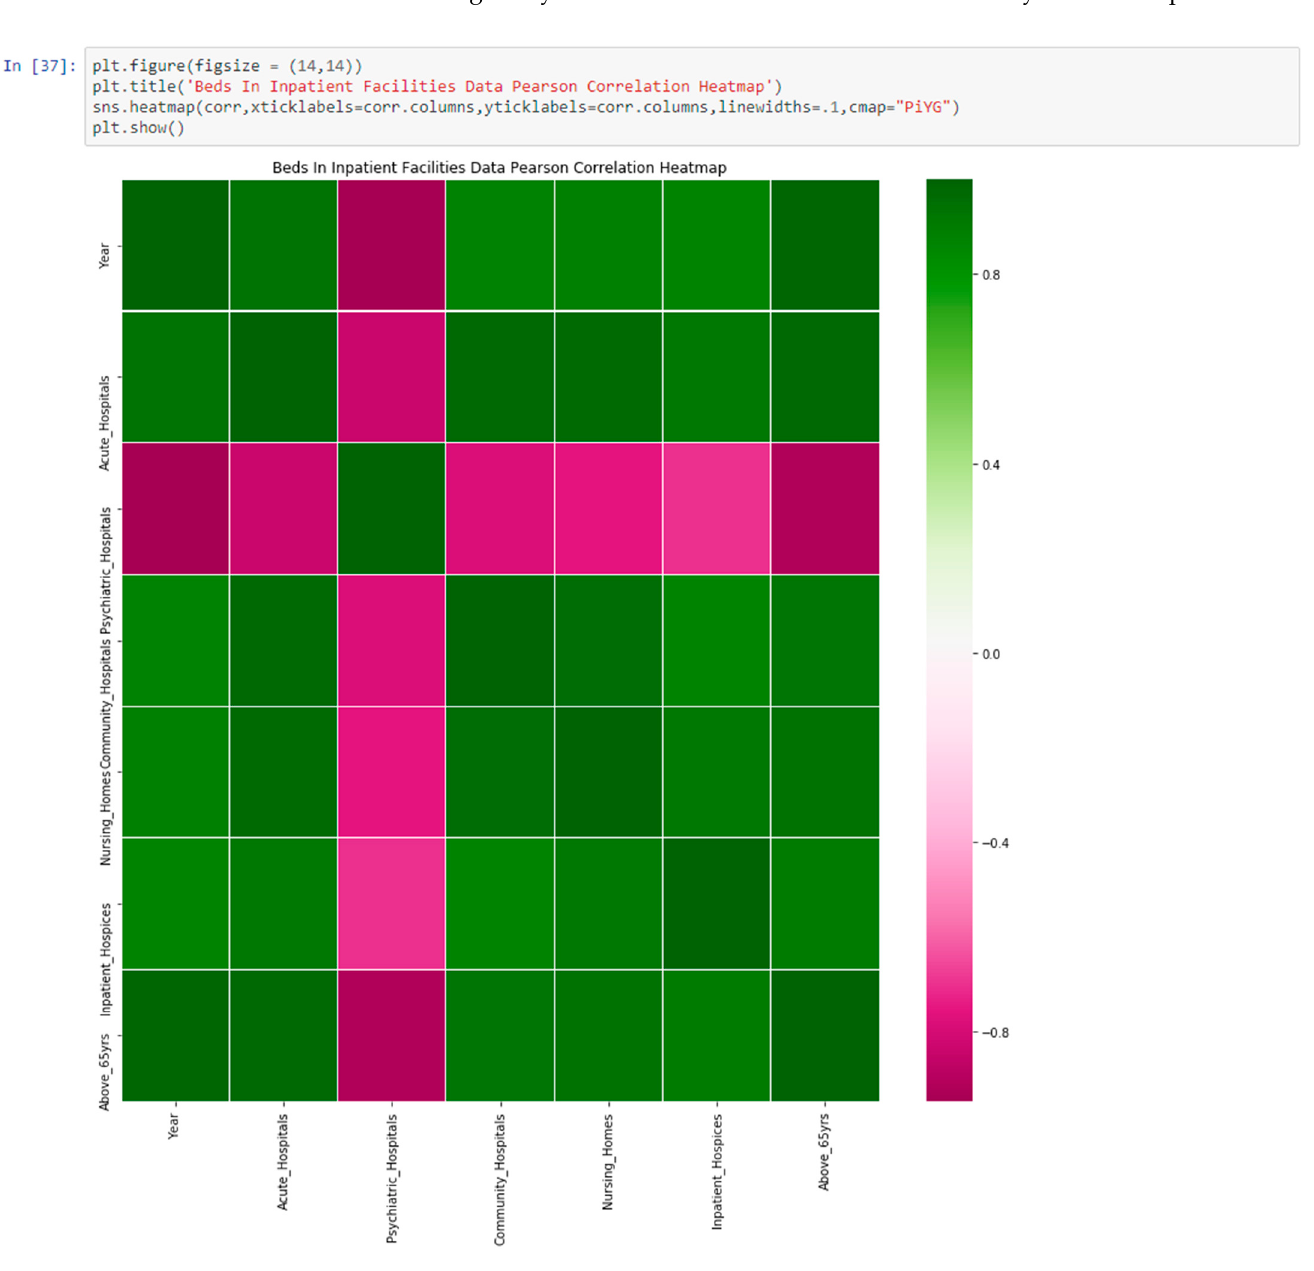
Figure 7. Heat Map showing the correlation between eldercare facilities and the resident population aged 65 onwards. Source: Developed for the study.